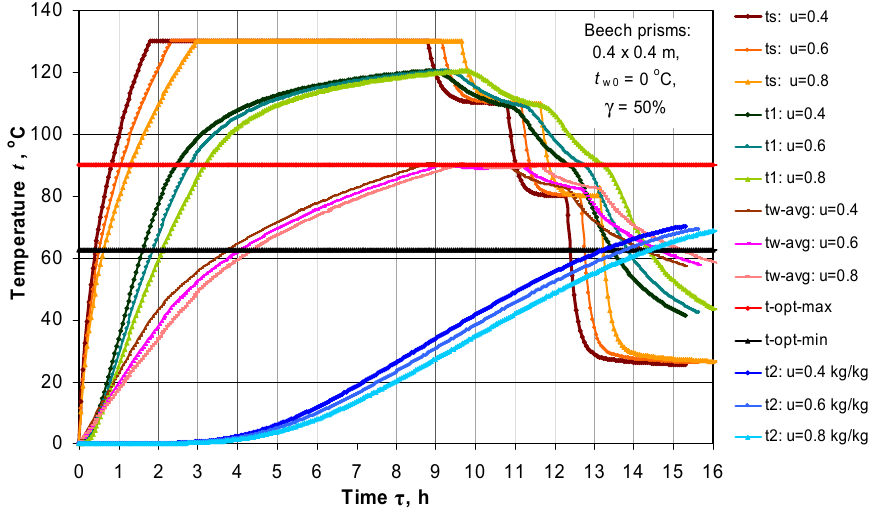
Figure 5. Changes in t s , t w-avg , and t in 2 characteristic points t 1 and t 2 of the prisms with d × b = 0.4 × 0.4 m and γ = 50% during their steaming in an autoclave and subsequent conditioning, depending on u and τ